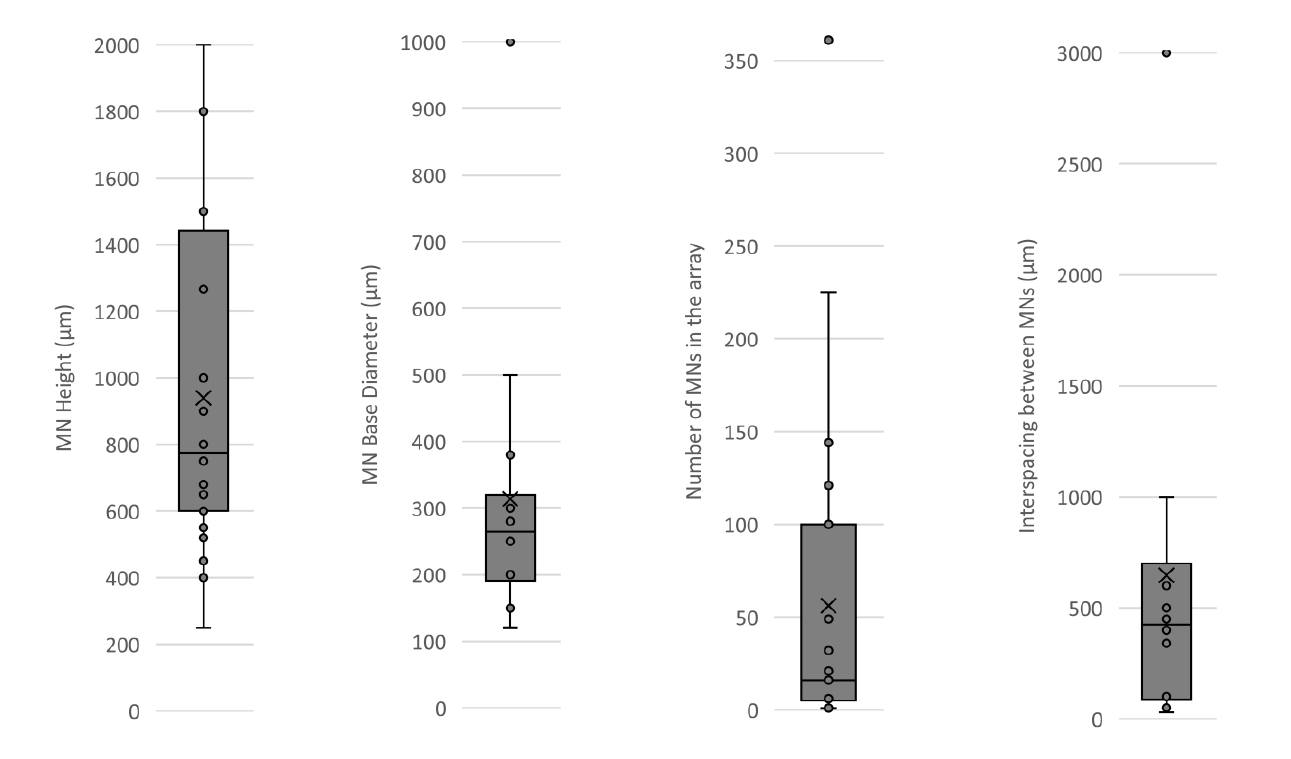
Table 2. Box charts of geometrical properties of MNAs reported in Table 1.